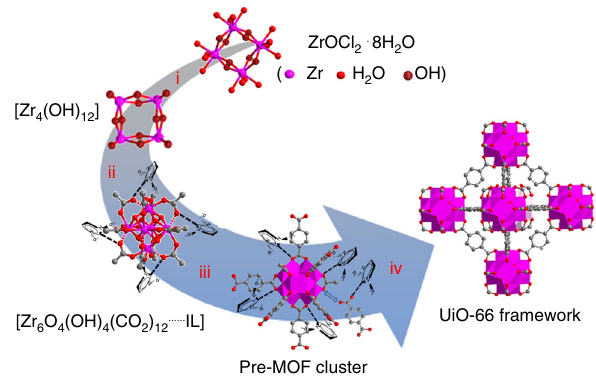
Fig. 4 Diagram illustrating the UiO-66 formation in IL. i ZrOCl 2 · 8H 2 O hydrolysis to polymeric hydroxide Zr 4 (OH) 12 . ii Complexation of zirconium by addition of HAc. iii IL-assisted linker exchange between HAc and H 2 BDC to produce pre-MOF cluster. iv UiO-66